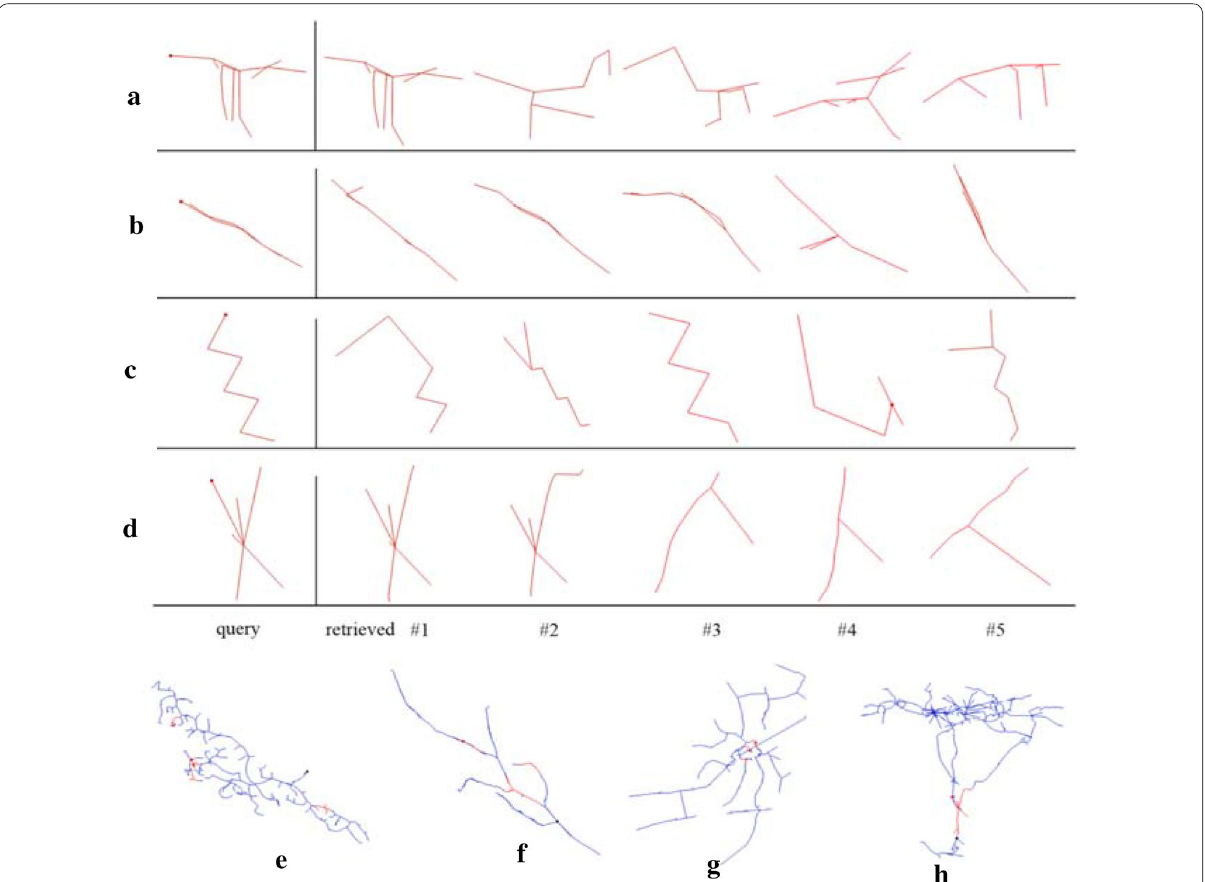
Fig. 3 Retrieved inaccurate substructures on a reconstruction. a – d are the query and its five retrieved substructures on reconstructions e – h ,